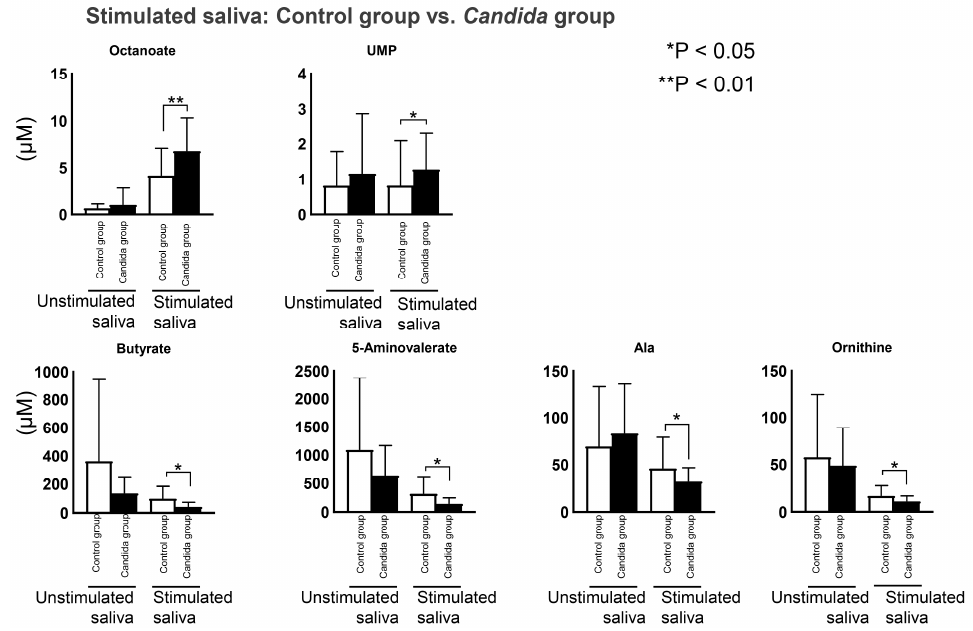
Figure 5. Inter-group comparison of metabolites detected in participants’ stimulated saliva. Salivary metabolites in the Candida group and control group were compared using the Mann–Whitney test. In stimulated saliva, four metabolites showed significantly lower concentration, and two metabolites showed significantly higher concentration.